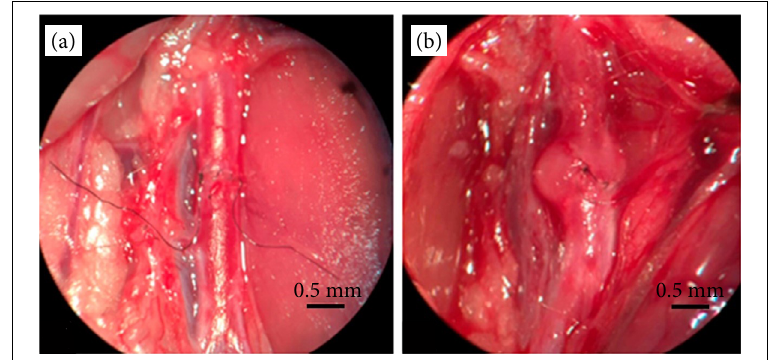
Figure 3 - Aspects of the anastomosis. (a) The caliber of the aorta at the level of the running suture. (b) The formation of an aneurysm at the level of the anastomosis, with a normal caliber of the distal aorta (magnification